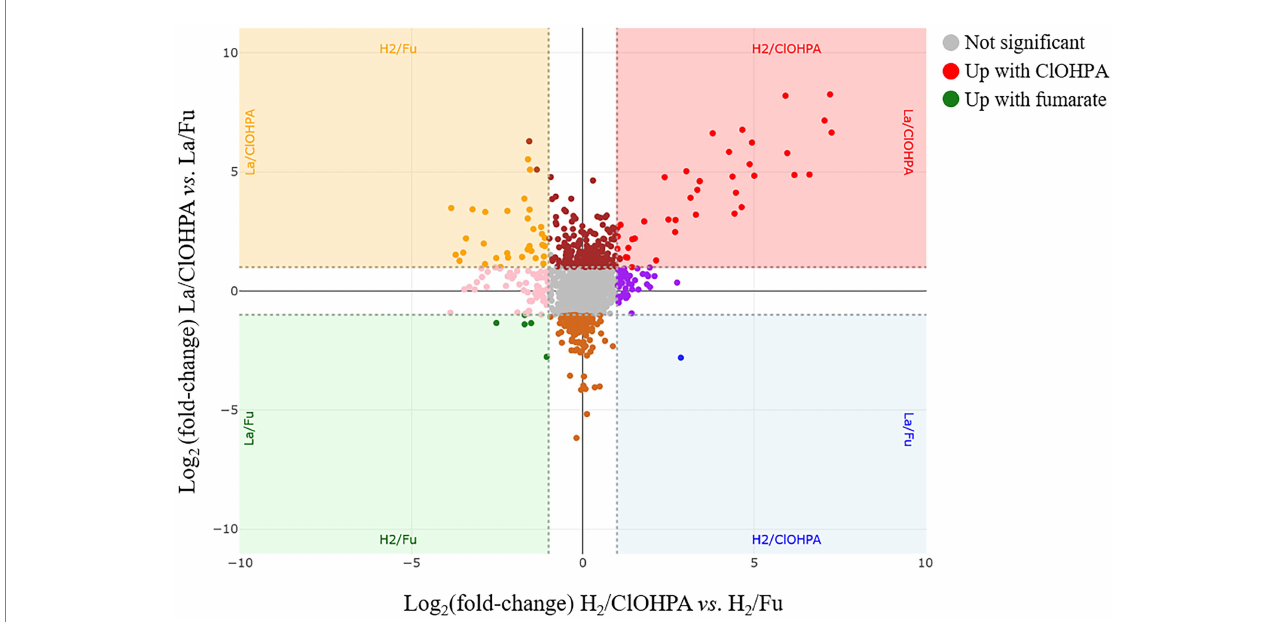
FIGURE 6 Scatter plot displaying the distribution of the proteins in the pairwise comparison of the proteomes from cells growing on H 2 /ClOHPA vs. H 2 /Fu and La/ ClOHPA vs. La/Fu conditions. Note that the proteins significantly up-regulated in ClOHPA conditions are displayed in red in the upper right corner, while those induced by fumarate are in green in the lower left corner of the scatter